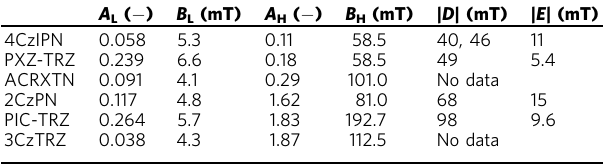
Table 1 Fitting parameters of magneto-electroluminescence under constant current of